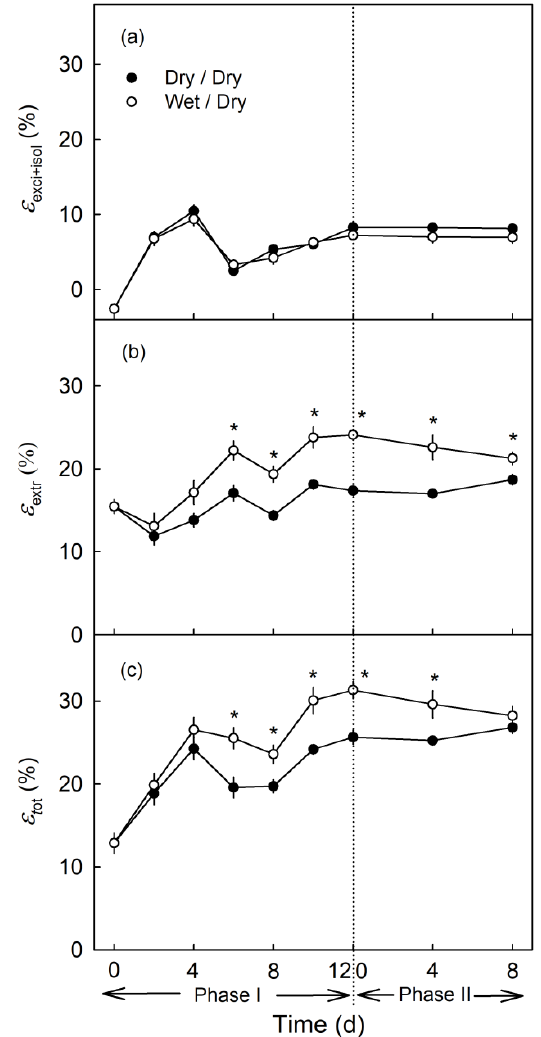
Figure 10. E ff ect of 12 d of moisture exposure (Phase I) on the elastic strain of the cuticular membrane (CM). Strain was quantified as the strain release during excision and isolation of the CM ( ε exci + isol ; a ) and following wax extraction of the CM ( ε extr ; b ) and the sum of ε exci + isol plus ε extr ( ε tot ; c ). Phase I represents the period of moisture exposure (wet). Phase II represents the period after moisture termination (dry). The dotted line indicates the end of Phase I and the beginning of Phase II. * indicates a significant di ff erence between dry / dry and wet / dry treatment at p < 0.05. Data represent means ± SE ( n = 8 to 20).